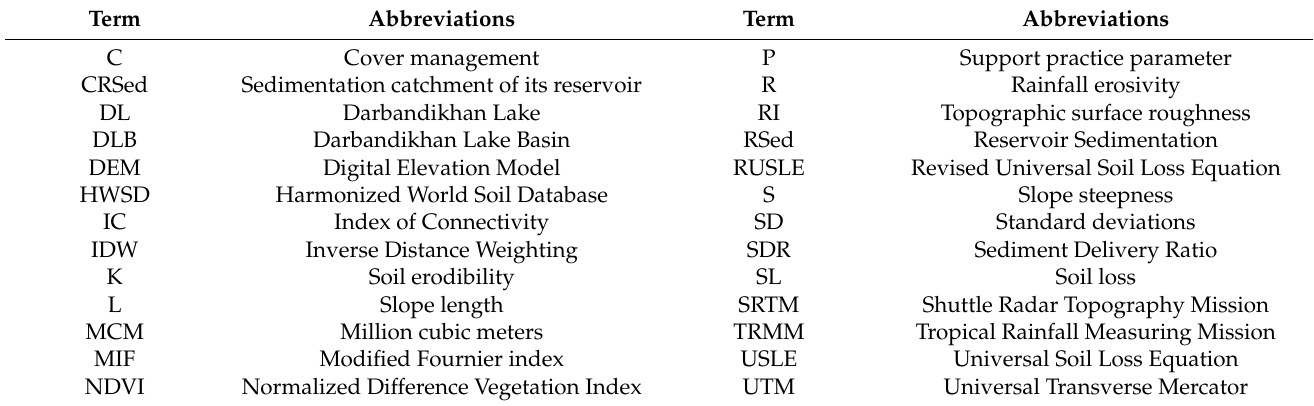
Table 1. List of acronyms and variables mentioned in the main text.